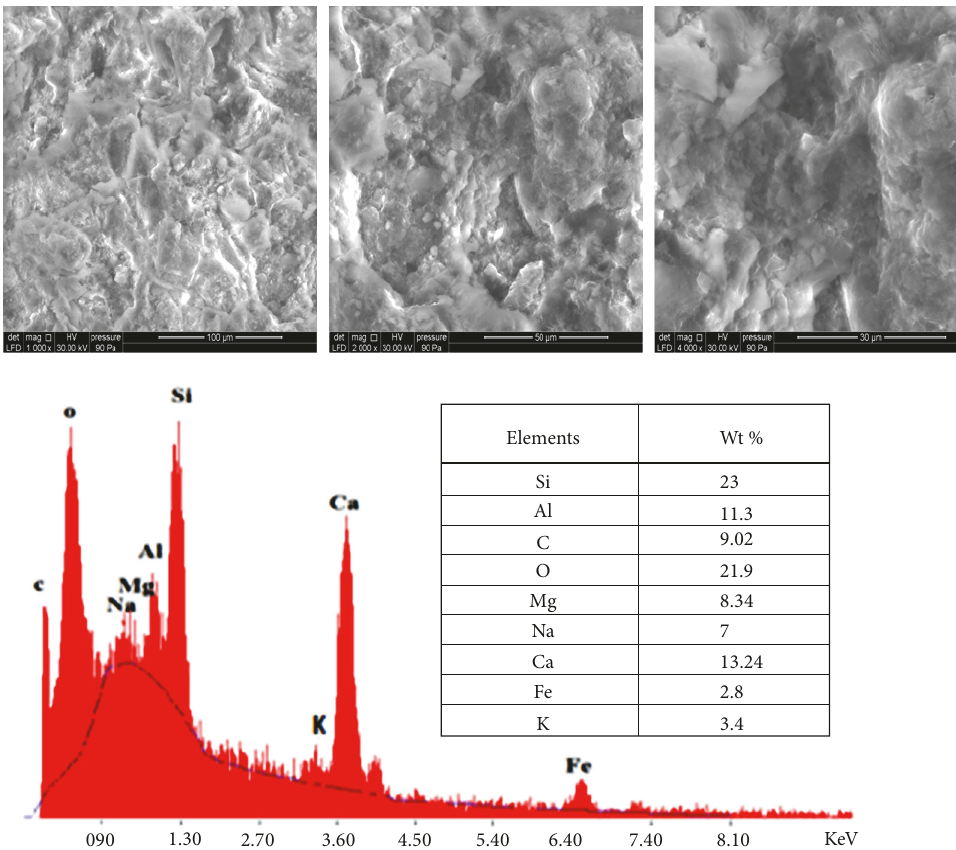
Figure 4: SEM images and EDX microanalysis spectrum of station N ∘ 1’s